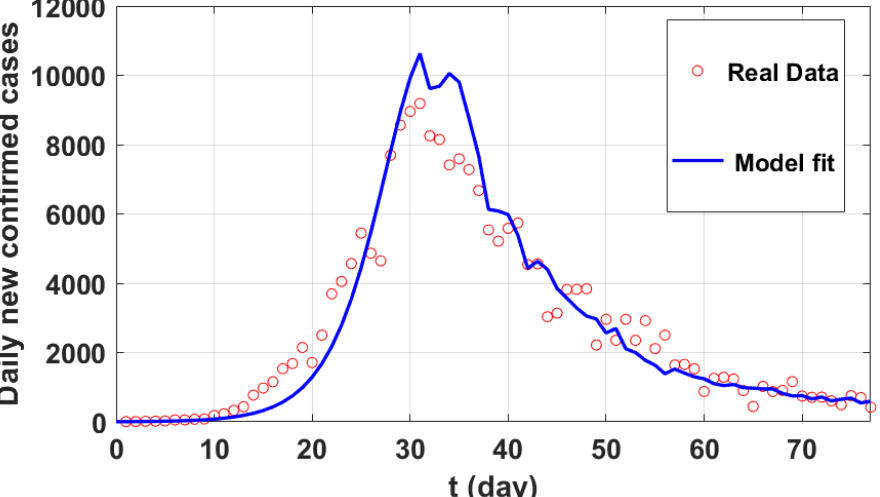
Figure 1. Numerical simulation for system (14–16) at H ∗ = 0.5, α = 0.9, α 1 = 0.87, σ 1 = σ 2 = σ 3 = 0.01, σ 4 = σ 5 = σ 6 = σ 7 = σ 8 =